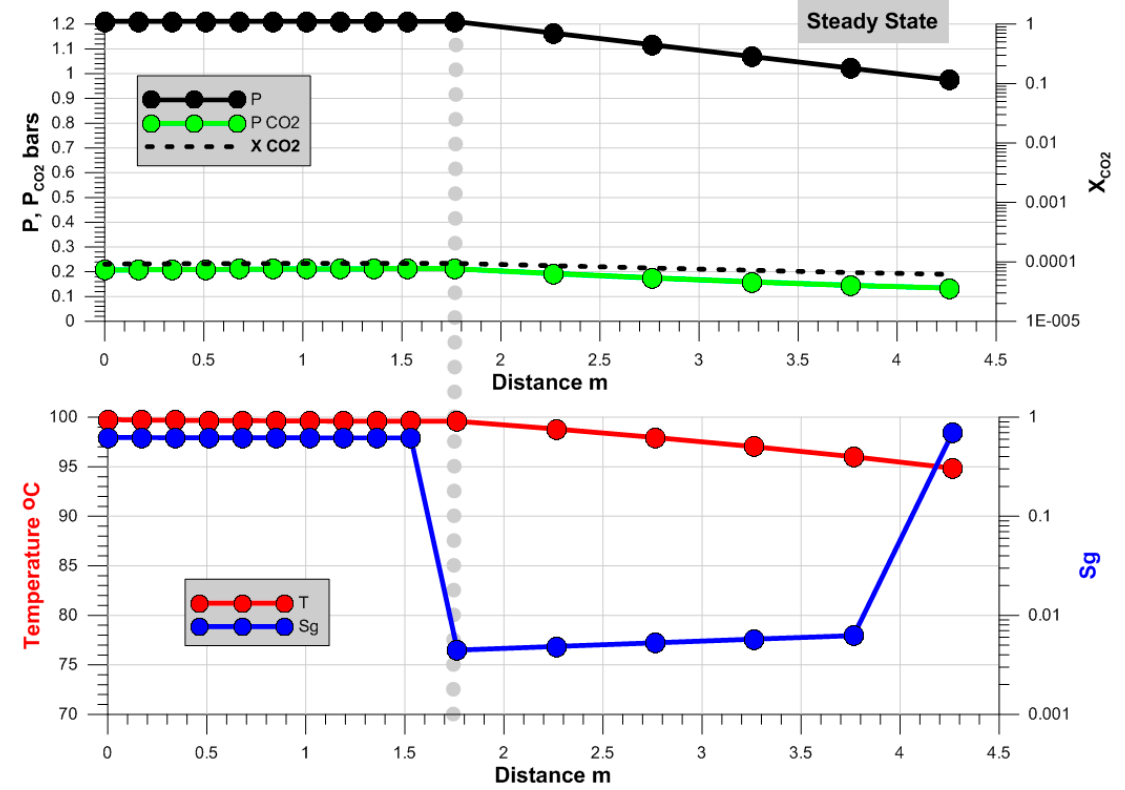
Figure 8. Steady-state model (#8_A3_NS) parameter distributions (temperature in °C, gas saturation Sg, pressure and partial CO 2 pressure P CO2 in bars, mass fraction of CO 2 in a liquid phase) along a streamline from hot water recharge element #11 to discharge element #56 of the model (see Figure 7 for model element names references). Vertical dotted line corresponds to the position of flow direction change from radial-horizontal to ascending-vertical.